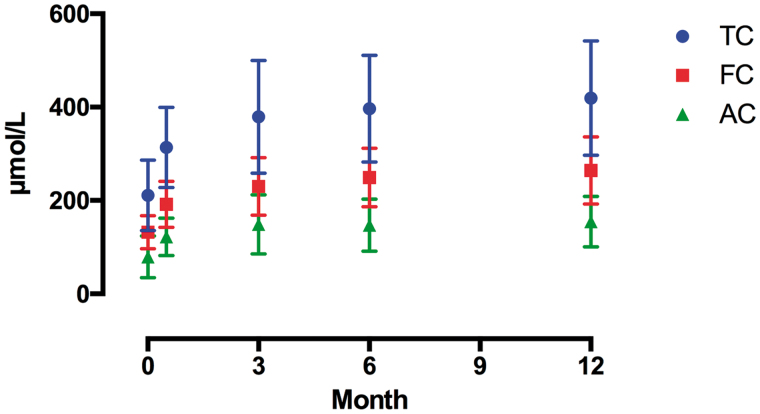
Levels of TC, FC, and AC after switching to the IV mode of administration were significant as per one-way ANOVA (p < .0001) and Dunnett’s multiple comparison tests (0 vs. 0.5, 0 vs. 3, 0 vs. 6, 0 vs. 12). TC: total carnitine; FC: free-carnitine; AC: acyl-carnitine.